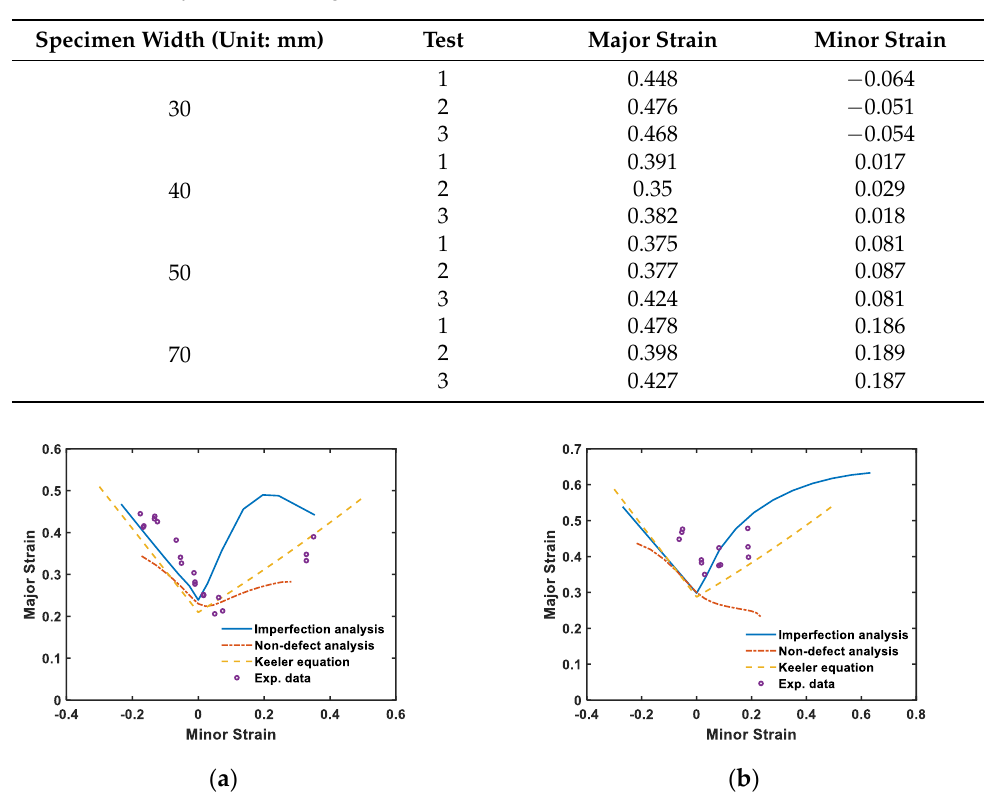
Table 5. Summary of the forming limit strain of low-carbon steel sheet.